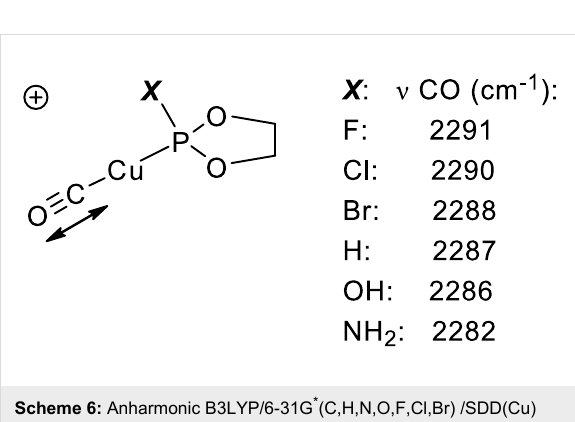
Scheme 6: Anharmonic B3LYP/6-31G * (C,H,N,O,F,Cl,Br) /SDD(Cu) CO-stretching frequencies to assess metal to ligand back bonding